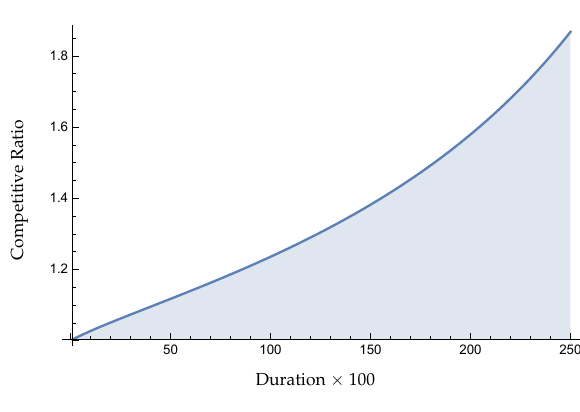
Figure 18. Competitive ratio t = 0.712, z = 0.1. Table 6. Results for progressive t , z for various parameters. Competitive ratios are well below